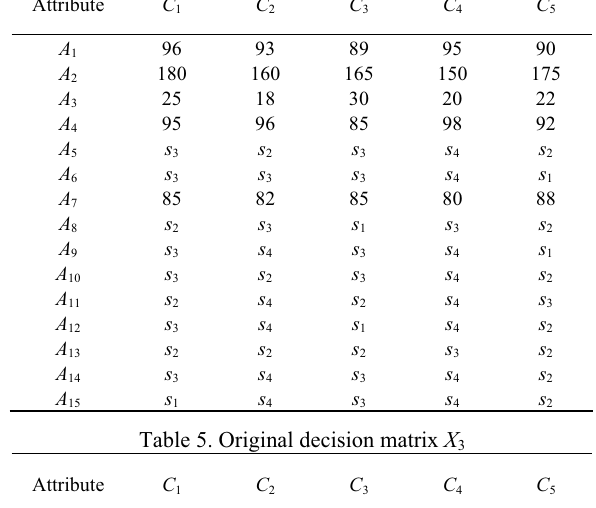
Table 4. Original decision matrix X 2